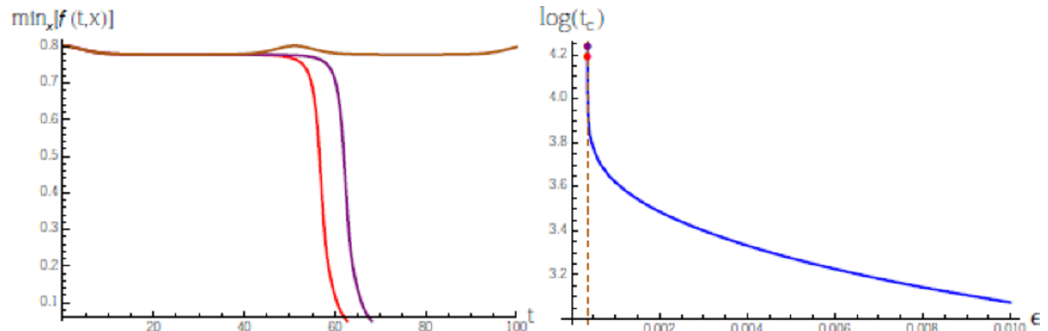
Figure 5 . Left: min x f ( t; x ) for the perturbed limit cycle solution for three deformations of the form (3.3) close to (cid:15) c , two above (red and purple) and one below (brown). Right: t c ( (cid:15) ) for the perturbed limit cycle solution (blue). The purple and red dots correspond to the purple and red simulations depicted on the left (cid:12)gure. The brown dashed line corresponds to the brown simulation on the left, for which no collapse is